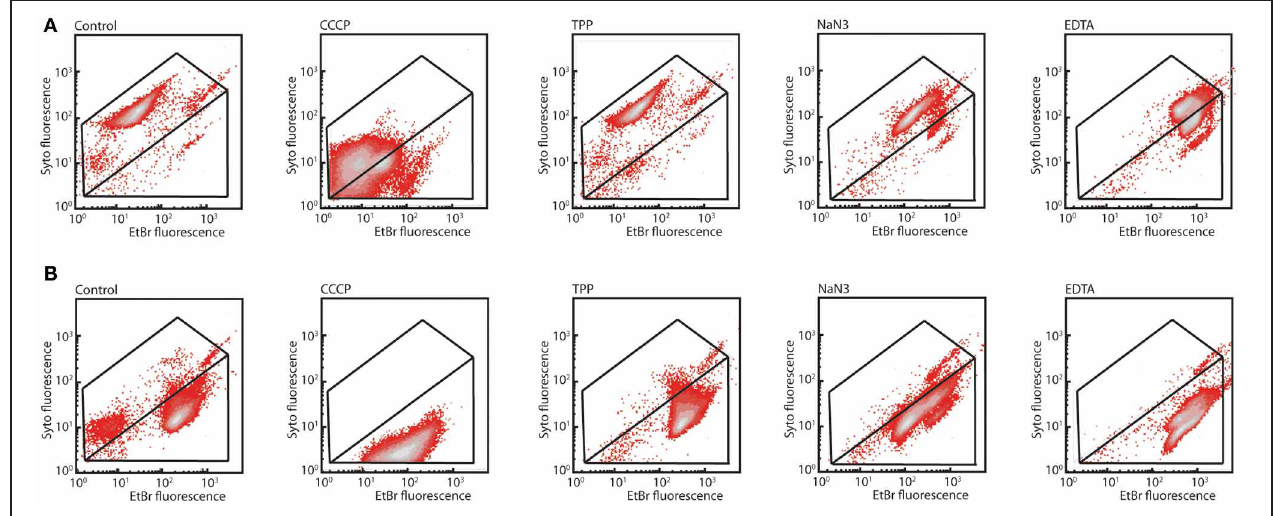
FIGURE 5 | Differential response of P. azelaica HBP1 wild-type or mex/oprM mutants to membrane energy uncouplers. (A) Exponentially growing cells of HBP1 on 5mM sodium succinate exposed or not to CCCP